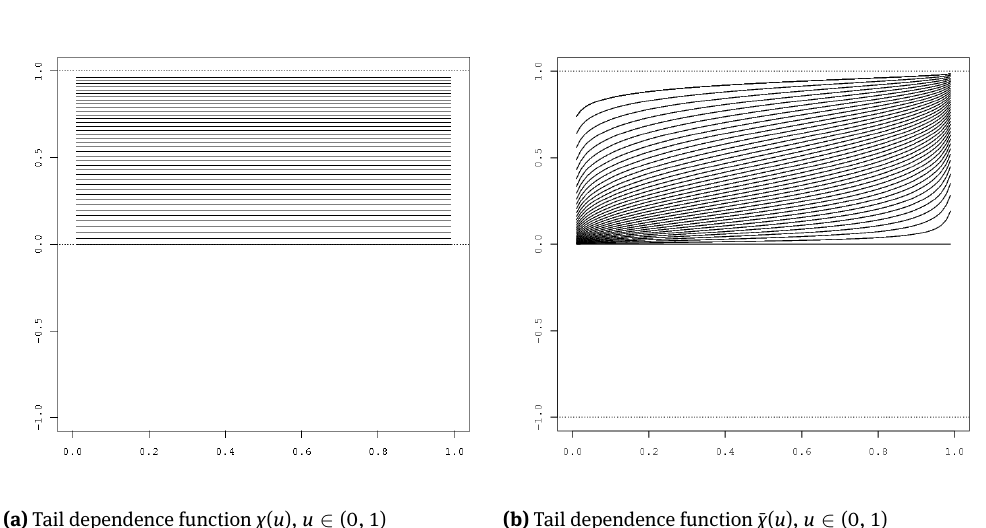
Figure 3: Tail dependence functions for the Gumbel-logistic distribution. The curves (top to bottom) correspond to parameter of dependence θ = 0.025, 0.050, 0.075, . . . , 0.950, 0.975 . In dotted line, the upper and lower bounds on χ (.) and ¯ χ (.)